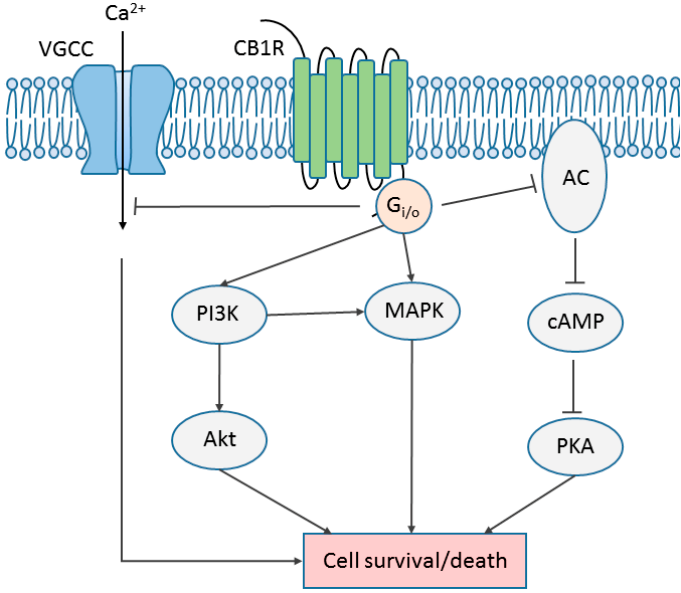
Figure 4. CB1R-modulated major signaling pathways. Typically, the CB1R is coupled to G i/o and inhibits the activity of adenylyl cyclase (AC), formation of cyclic adenosine monophosphate (cAMP), and the activity of protein kinase A (PKA). Under certain circumstances, the CB1R can switch its coupling of G protein from G i/o to G s or G q . The CB1R is able to suppress calcium influx via voltage-gated calcium channel (VGCC). Several mitogen-activated protein kinases (MAPKs), including ERK1/2, p38, and JNK, are activated by the CB1R. The phosphoinositide 3-kinase (PI3K)/protein kinase B (Akt) pathway is activated by CB1R as well. Depending on the ligand and subcellular environment, the outcome of CB1R-mediated signaling could be promotion of cell survival or cell death. Arrows indicate stimulation; blunted arrows indicate inhibition.